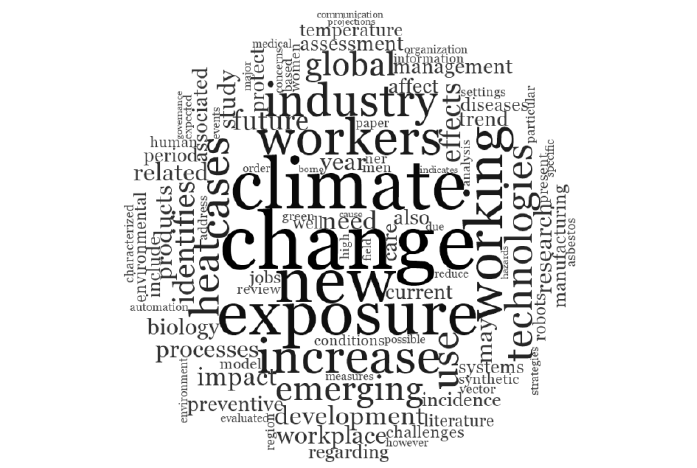
Figure 2. Distribution of terms based on their frequency of use in article